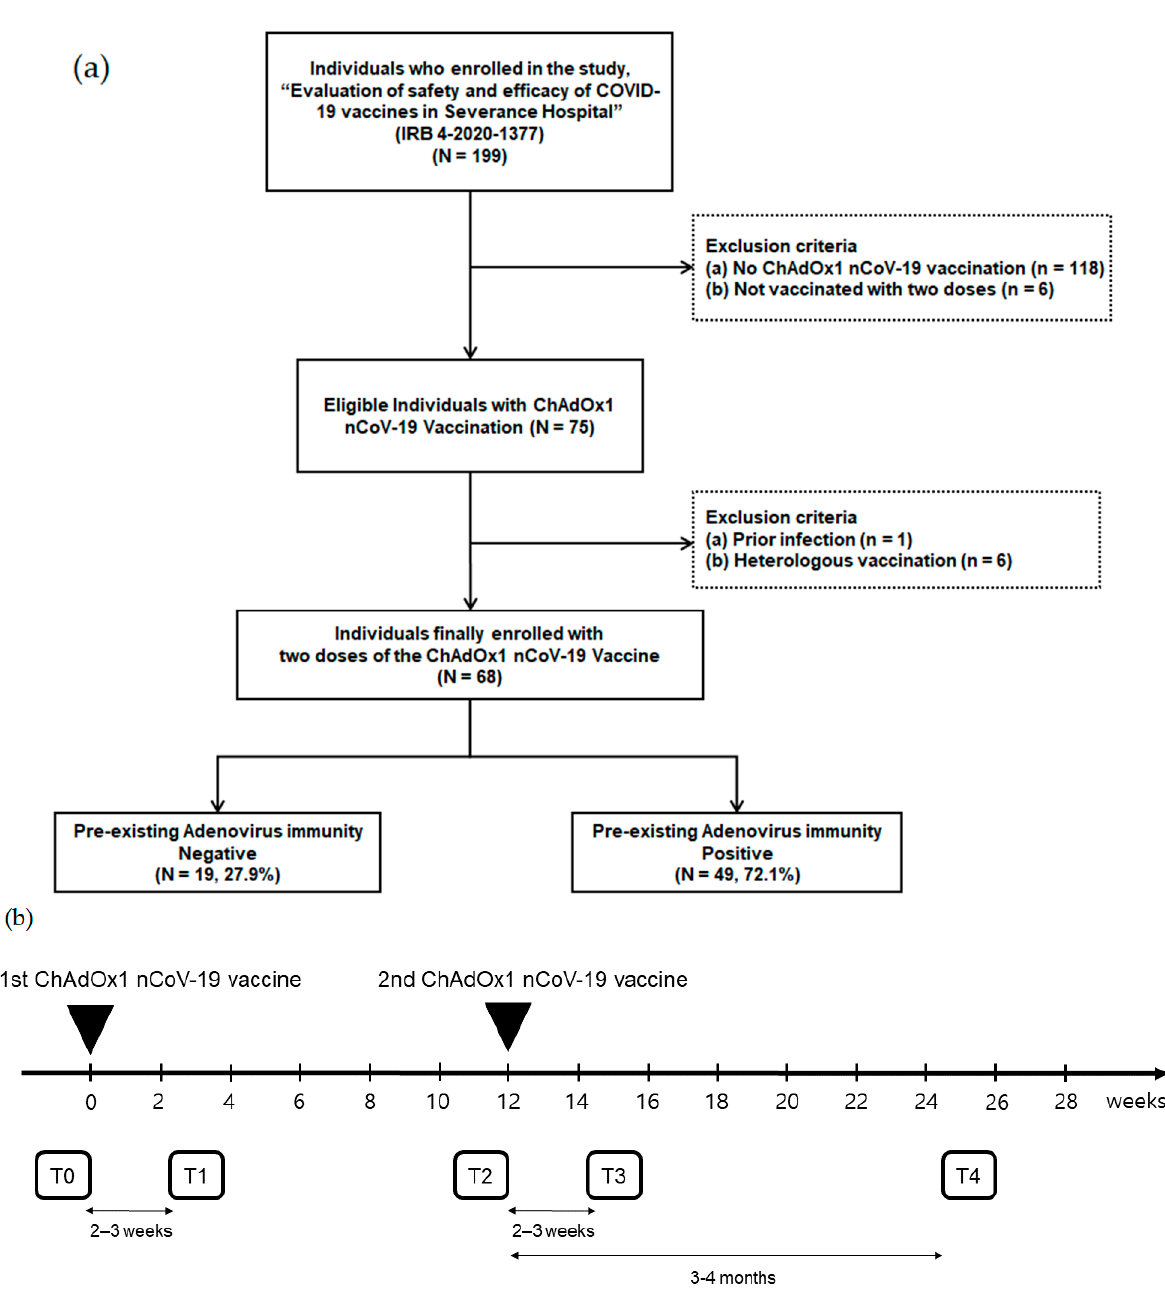
Figure 1. ( a ) Flow chart of individuals with ChAdOx1 nCoV-19 vaccination according to pre-existing adenovirus immunity; ( b ) Timetable of individuals with ChAdOx1 nCoV-19 vaccination.